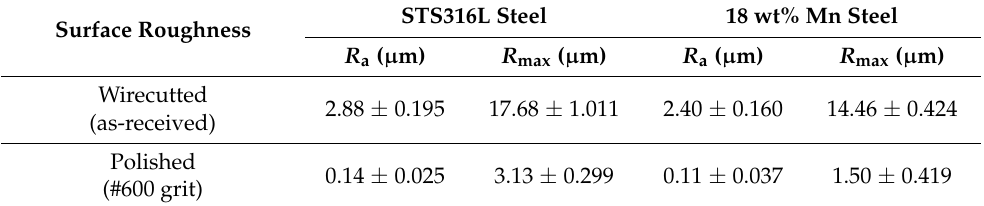
Figure 1. SEM images of specimen surfaces, either as-received or polished (using 600-grit sandpaper). Table 3. Surface roughness of